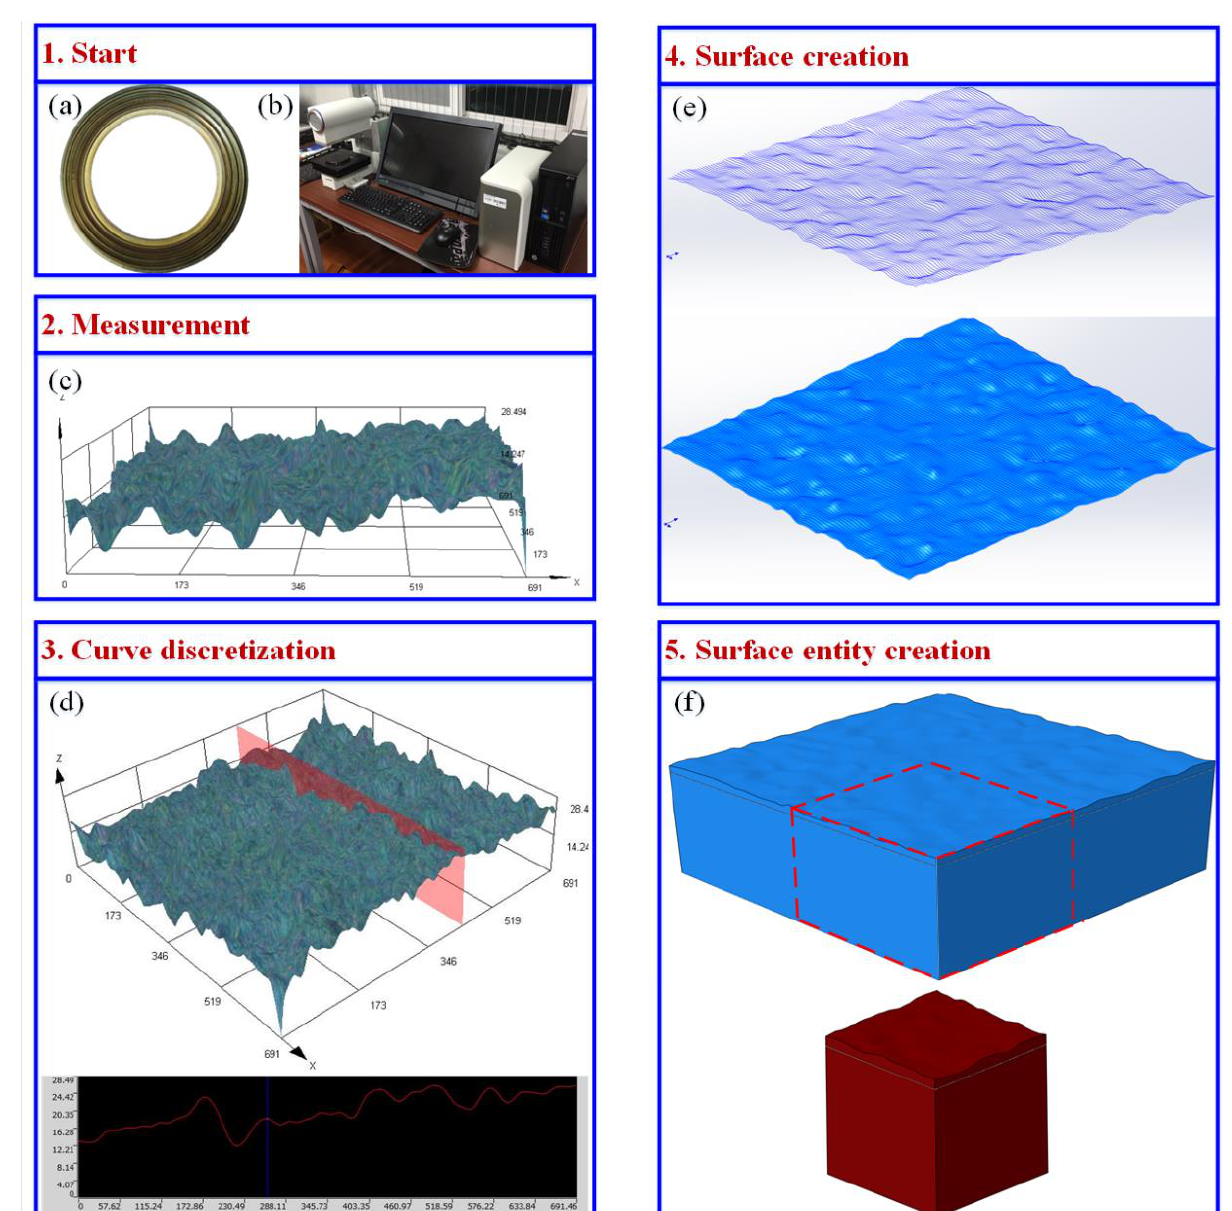
Figure 3. Digital geometric model modeling process with real sealing face topography: ( a ) corru- gated gasket, ( b ) OLYMPUS DX510 microscope, ( c ) measurement of the gasket surface, ( d ) curve discretization, ( e ) surface creation, ( f ) surface entity creation.